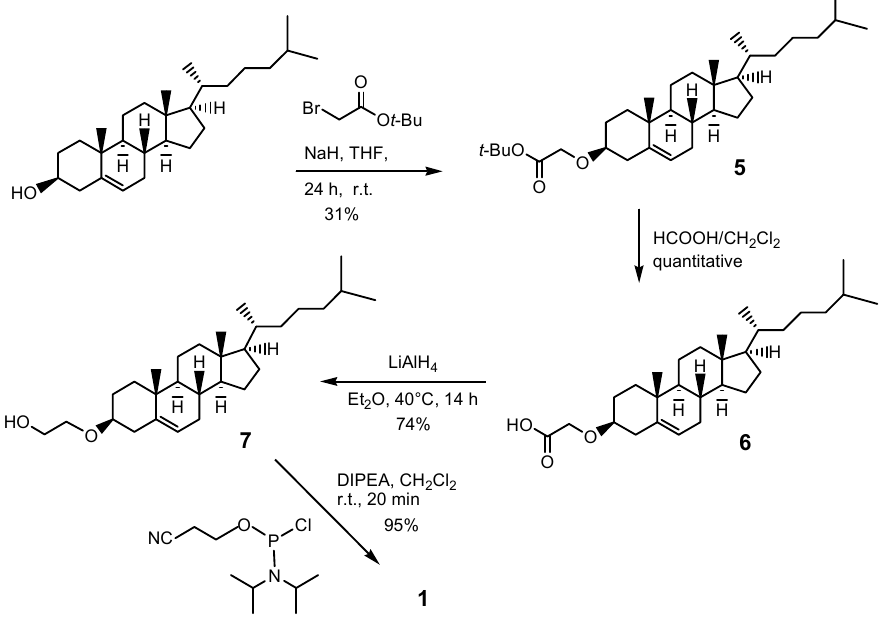
Scheme 1. Synthesis of phosphoramidite derivative 1